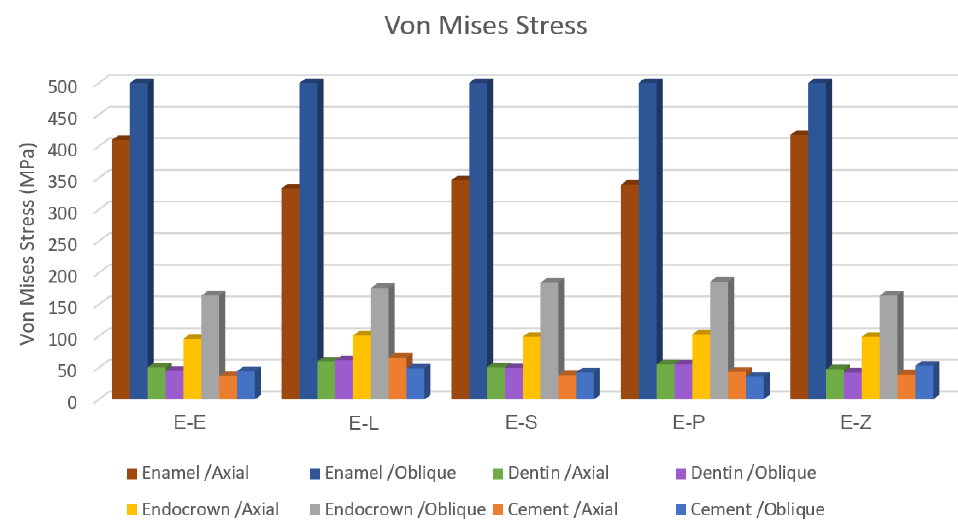
Figure 5. The maximum values of von Mises stress (MPa). E-Z: translucent zirconia model, E-P: polymer-infiltrated ceramic network model, E-S: zirconia-reinforced lithium silicate ceramic model, E-L: resin nanoceramic model and E-E: lithium disilicate glass ceramic model.